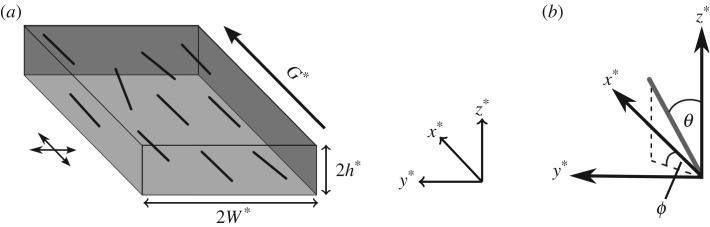
Schematic of the flow of a fibre-laden fluid, forced by pressure gradient G* with a distribution of orientation, in a thin rectangular channel. (a) Rectangular channel of width 2W* and depth 2h* and the x*-axis is the molecular orientation axis. The orientation parameter is calculated as the proportional difference in orientation parallel and perpendicular to the molecular orientation axis, highlighted by the arrows to the left of the channel. Note that for oscillating flow, the pressure gradient is replaced with G*eiω*t* for frequency of oscillations ω*. (b) The orientation angles θ∈[0, π] and ϕ∈[0, 2π) away from the coordinate axis describe the orientation of the fibres.